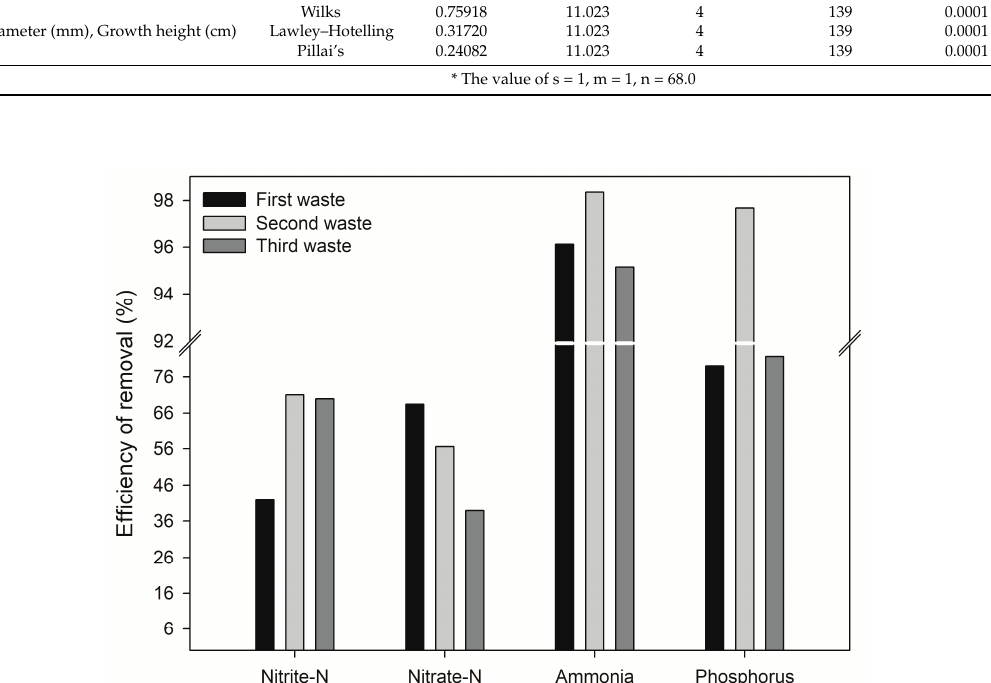
Figure 5. Above-ground biomass productions of seedlings of Rhizophora mangle in the wastewater treatment and seawater (control) artificial wetland habitats. See text for further details.